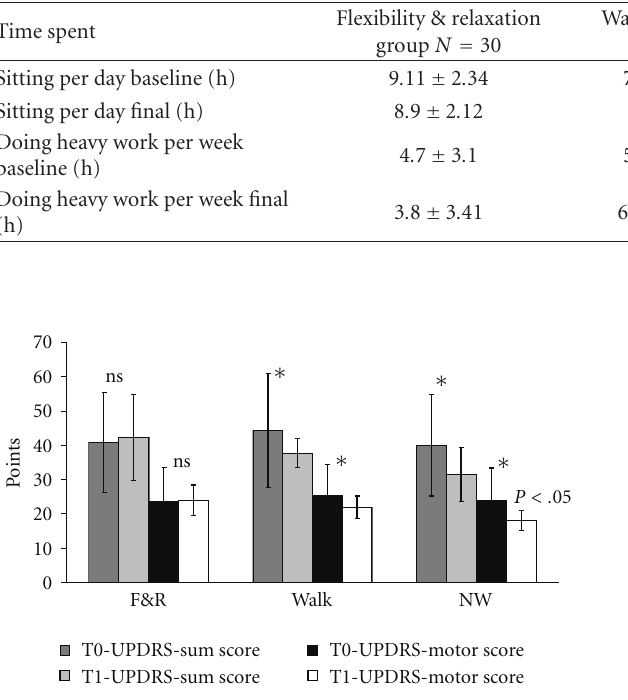
Figure 4: The UPDRS sum score and UPDRS motor score (subscale 3) did not decrease in the flexibility and relaxation group but decreased significantly in the Nordic walking and walking group resulting in a group e ff ect. T0 = first assessment, T1 = second assessment, F&R = Flexibility and Relaxation ∗ P < . 05, error bars indicate standard